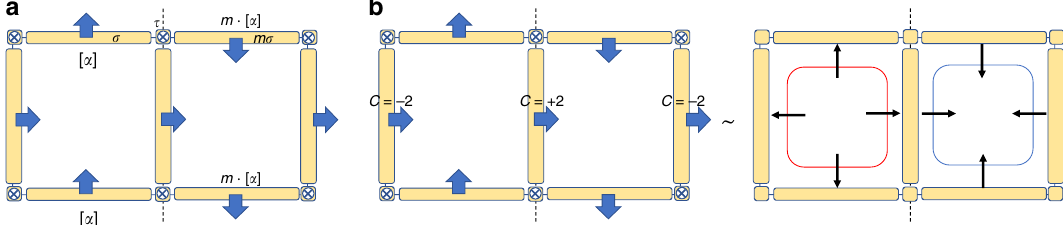
for space group Pm in one unit cell. The fi gure 2 ; 1 , where two 3-bubbles are decorated to the 3-cells. The outward 3 ; 1